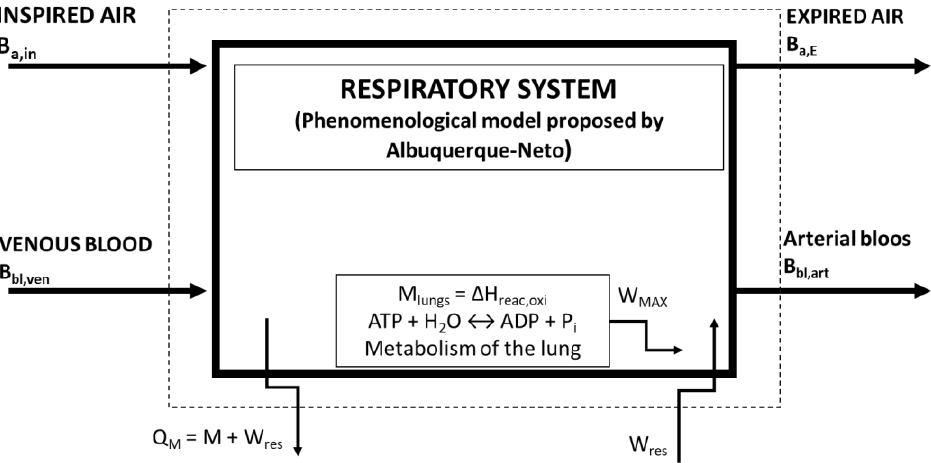
Figure 3. Control volume as proposed based on previous studies of the group [7,8] and used in the present paper. Modified and adapted from [7,8].